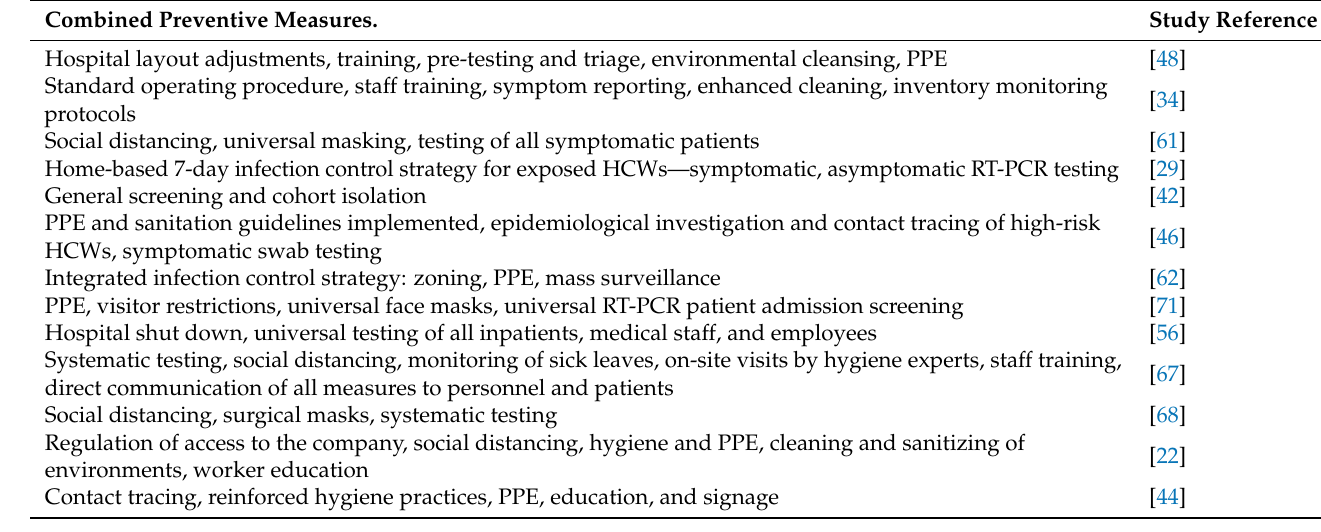
Table 5. Map of combined workplace COVID-19 measures implemented.